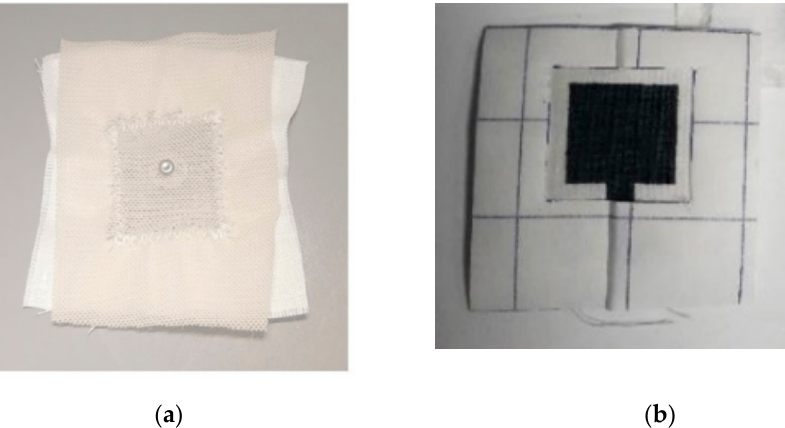
Figure 10. ( a ) Sewn ECG electrode; ( b ) screen printed ECG electrode. (Reprinted with permission from ref [39] Hasan, Muhammad (2009)).